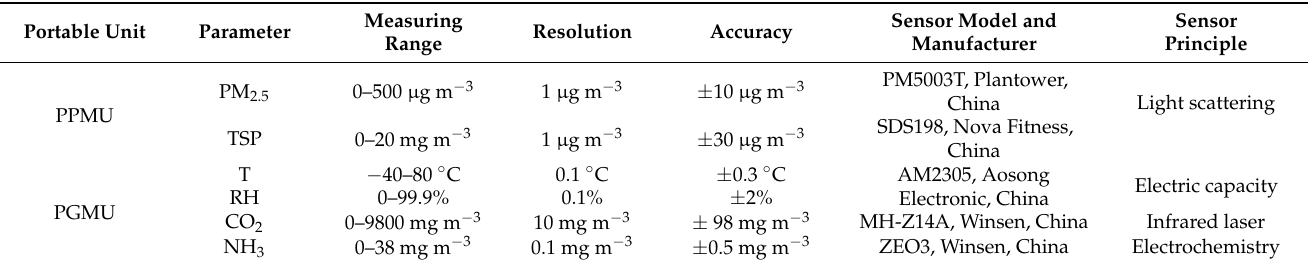
Table 1. Technical specification of sensors integrated into portable particulate monitoring unit (PPMU) and portable gas monitoring unit